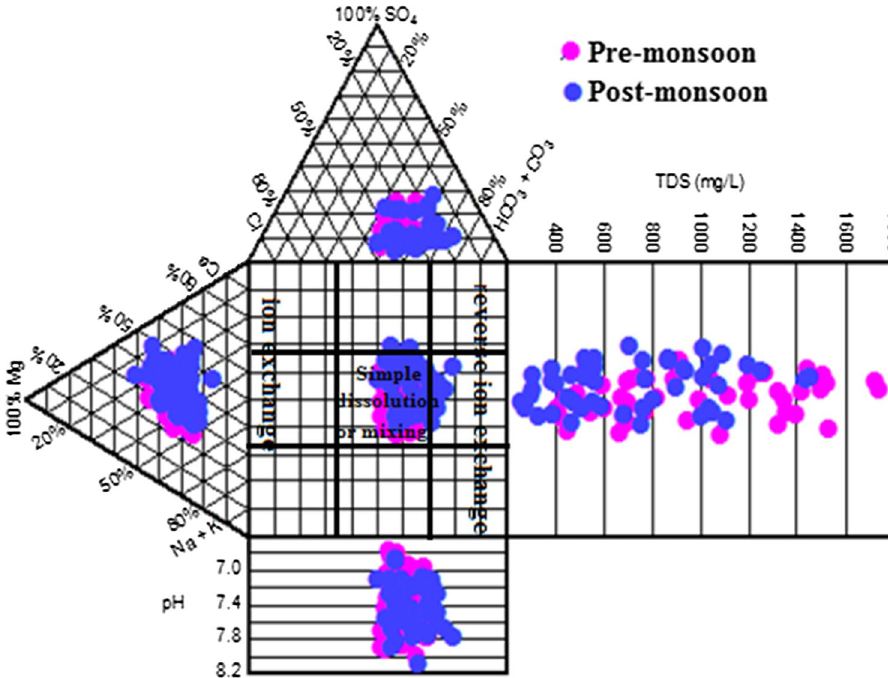
Fig. 7 Durov diagram for Bokaro district groundwater